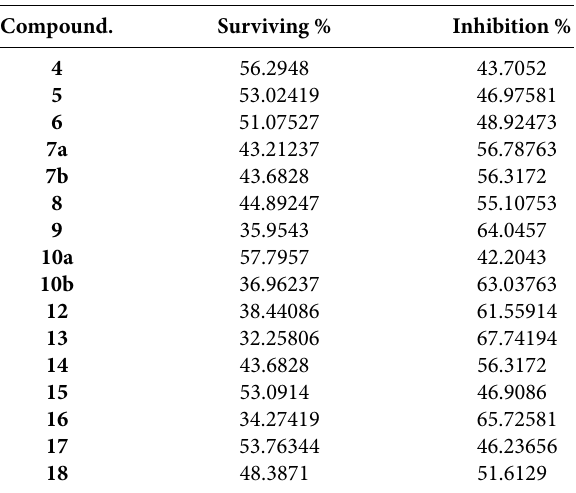
Table 1. Growth inhibition (%) of Single Dose Experiment on HCT- 116 (colon adenocarcinoma) cell line (100 μg/mL) of the synthe- sized compounds after 72 h of incubation. Compound.